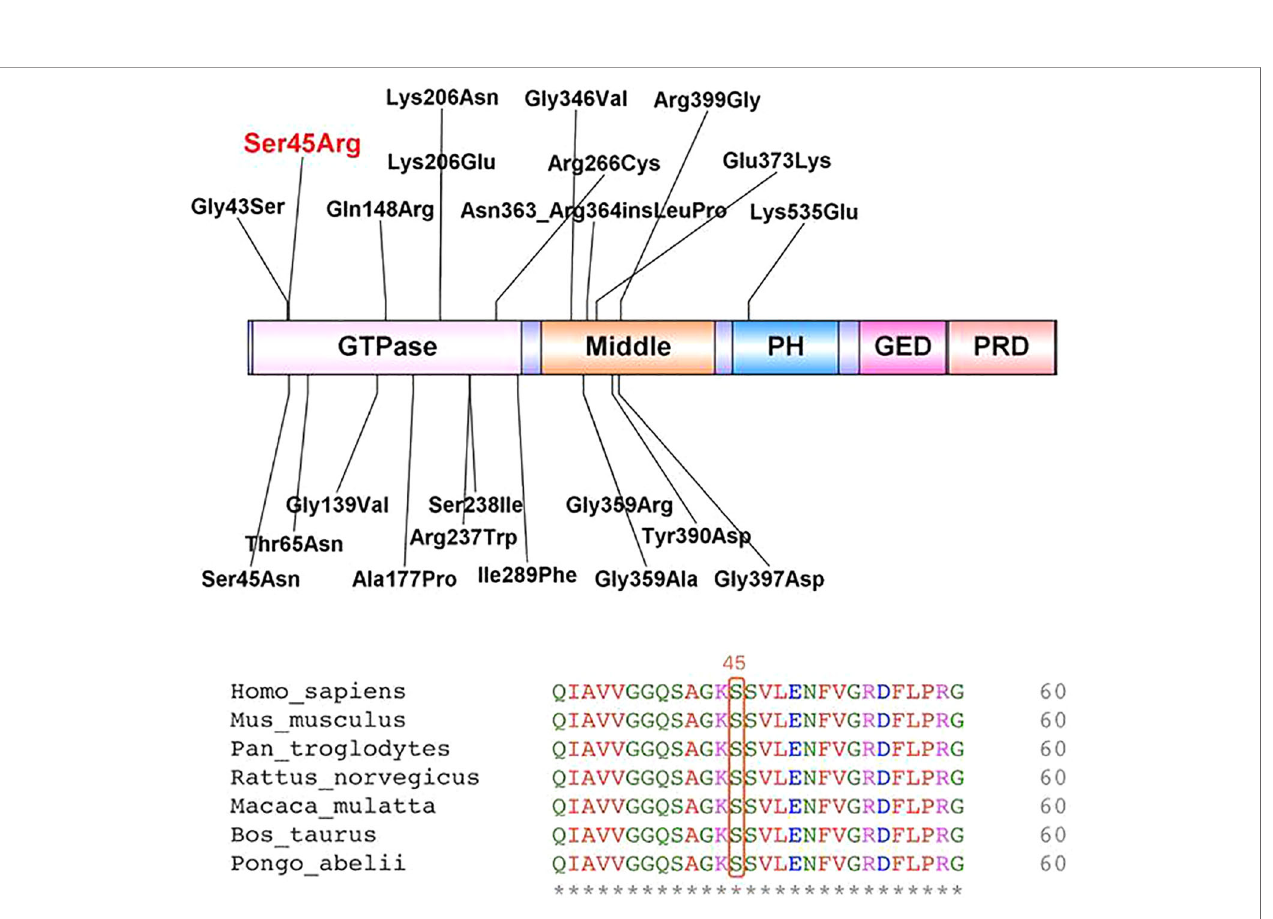
FIGURE 6 | Locations of identi fi ed variants in dynamin-1 protein structure (top) and amino acid sequence of the present variant (bottom).